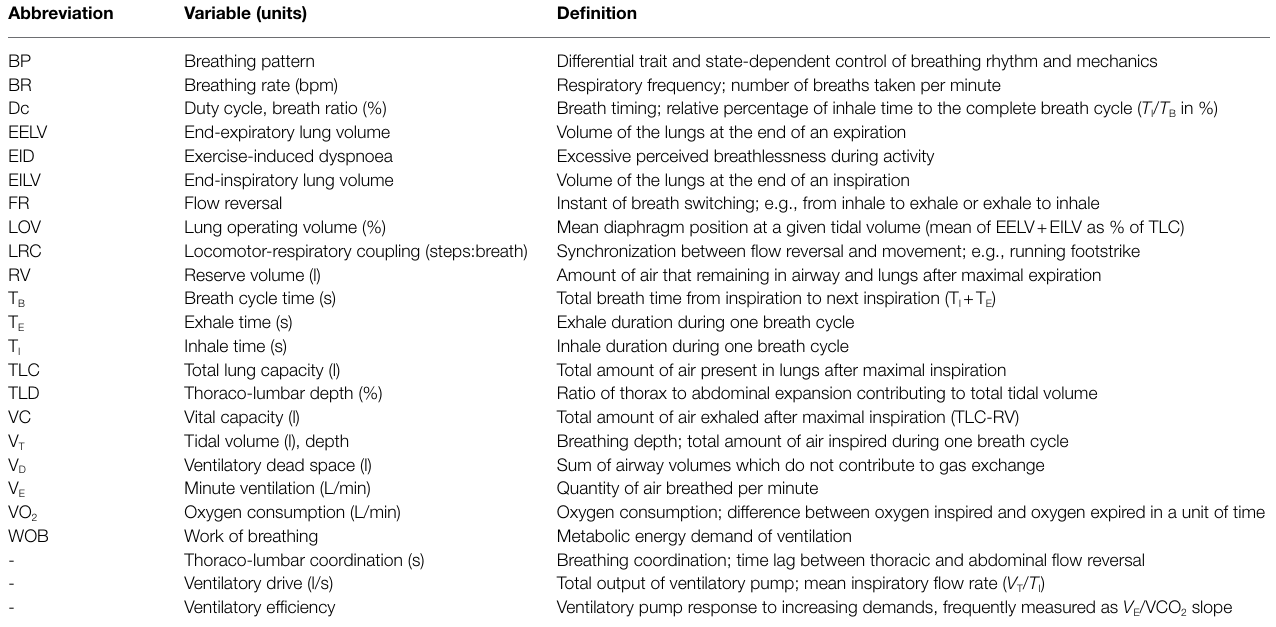
TABLE 1 | List of breathing pattern components and common abbreviations. Abbreviation Variable